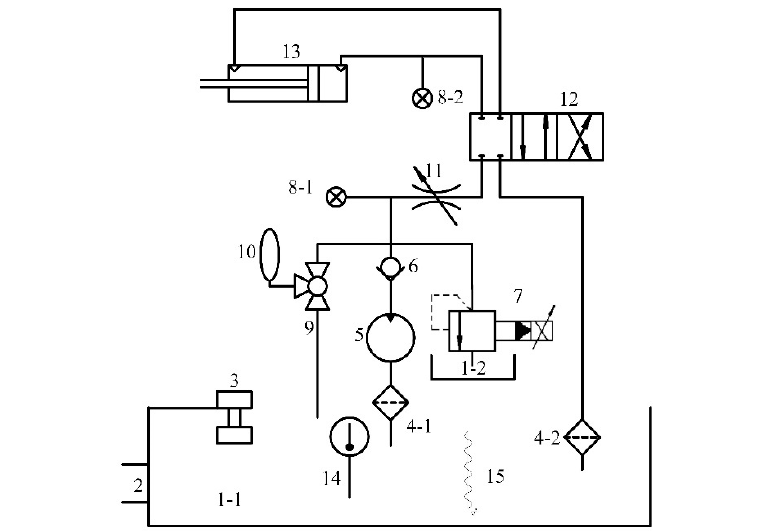
Figure 1. Principle diagram of hydraulic system.